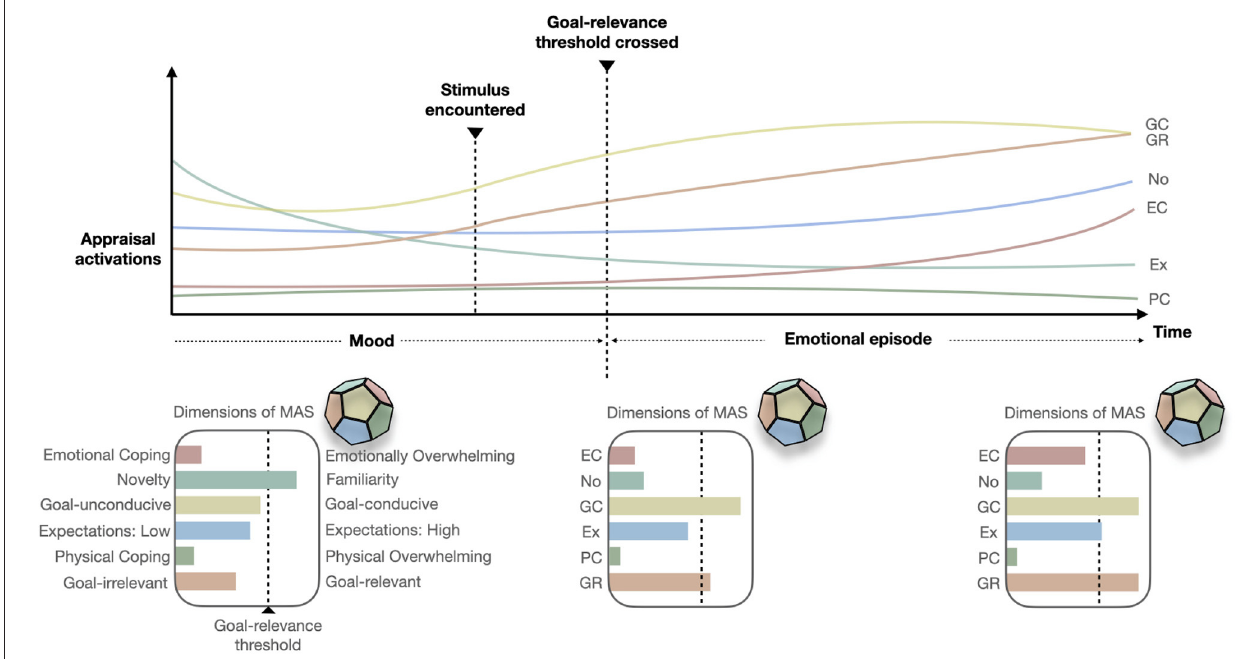
FIGURE 2 | A visual representation of the dynamic changes in appraisal dimensions of the multidimensional appraisal space (MAS) in the CODA model. Only a few key appraisals are plotted for illustrative purposes. MAS is truly representative of n dimensions. The timeline shows a hypothetical encounter with a stimulus the drives changes in appraisals. As the goal-relevance appraisal crosses a threshold general cognitive processes become a subjectively perceived emotional episode. The plots below the timeline offer snapshots of MAS at different time stamps and highlight the activation of each appraisal dimension. Note that the extremes of each dimension are not clearly positive or negative. Appraisal dimensions code: GR, Goal-relevance; GC, Goal-conduciveness; No, Novelty; Ex, Expectations; EC, Emotional coping; PC, Physical